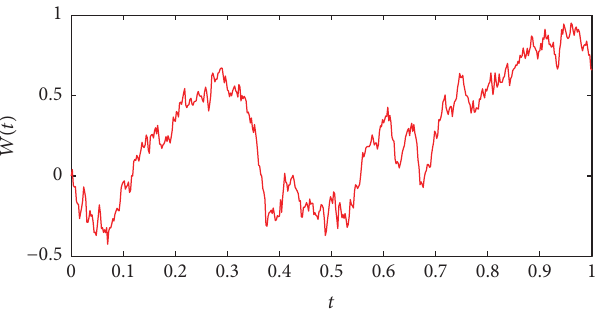
Figure 7: Schematic diagram of Wiener